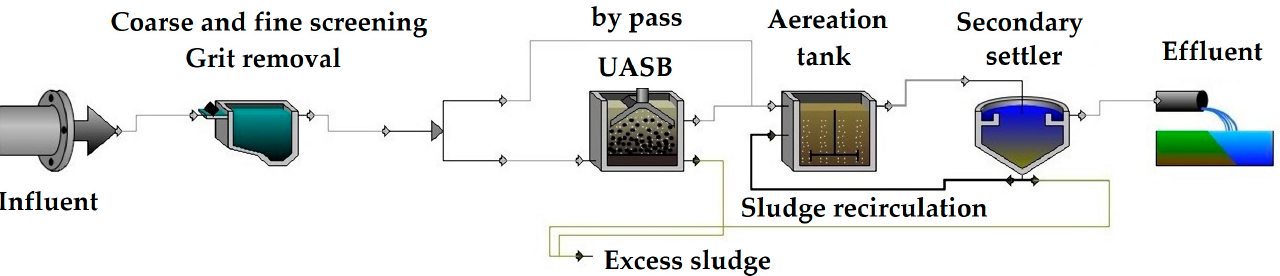
Figure 1. Flowsheet of the Tunja sewage treatment plant including a UASB reactor with activated sludge post-treatment. Table 1. Design values adopted for the Tunja